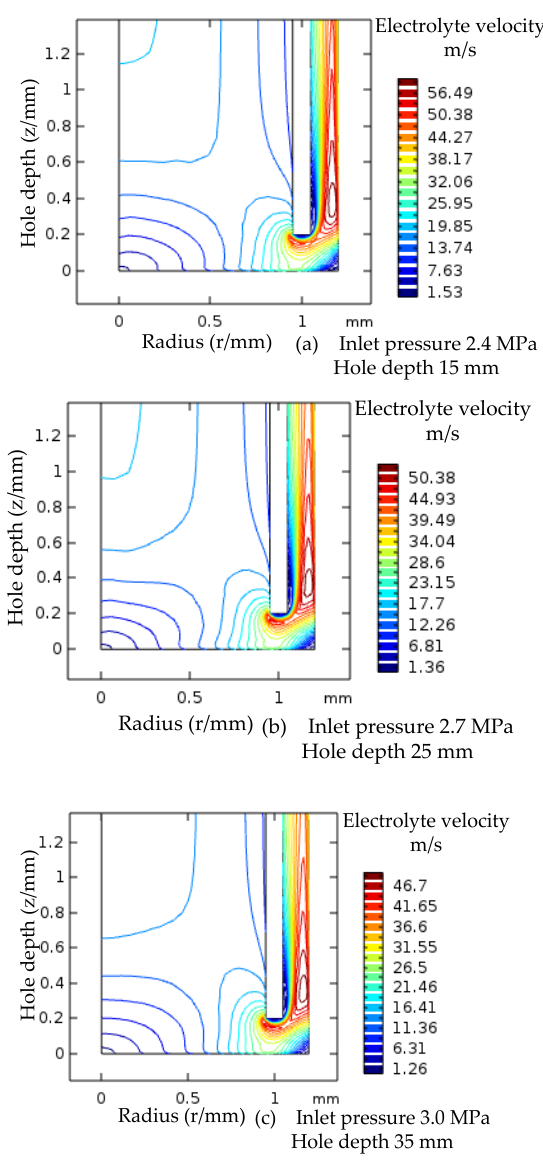
Figure 12. Velocity contour map of the low-speed region after